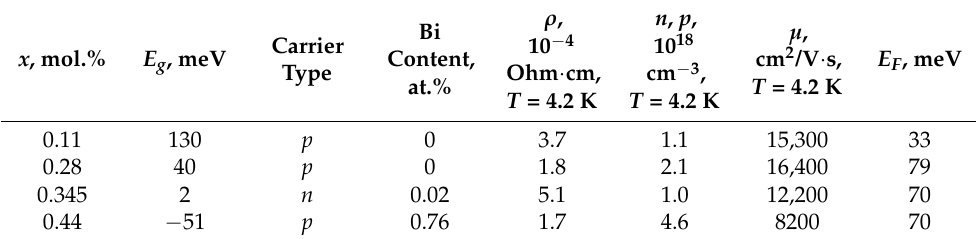
Table 1. Characterization of the Pb 1 − x Sn x Te samples studied. The SnTe content x was determined by the XRD; the energy gap E g was calculated using the x value as described in the text; the Bi content was determined by controlling the Bi flux in the MBE setup; the carrier type, resistivity ρ , free carrier concentration n , p , carrier mobility µ were determined through the resistivity and Hall effect measurements; position of the Fermi energy E F with respect to the band edges was calculated using the Kane dispersion relation as described in the